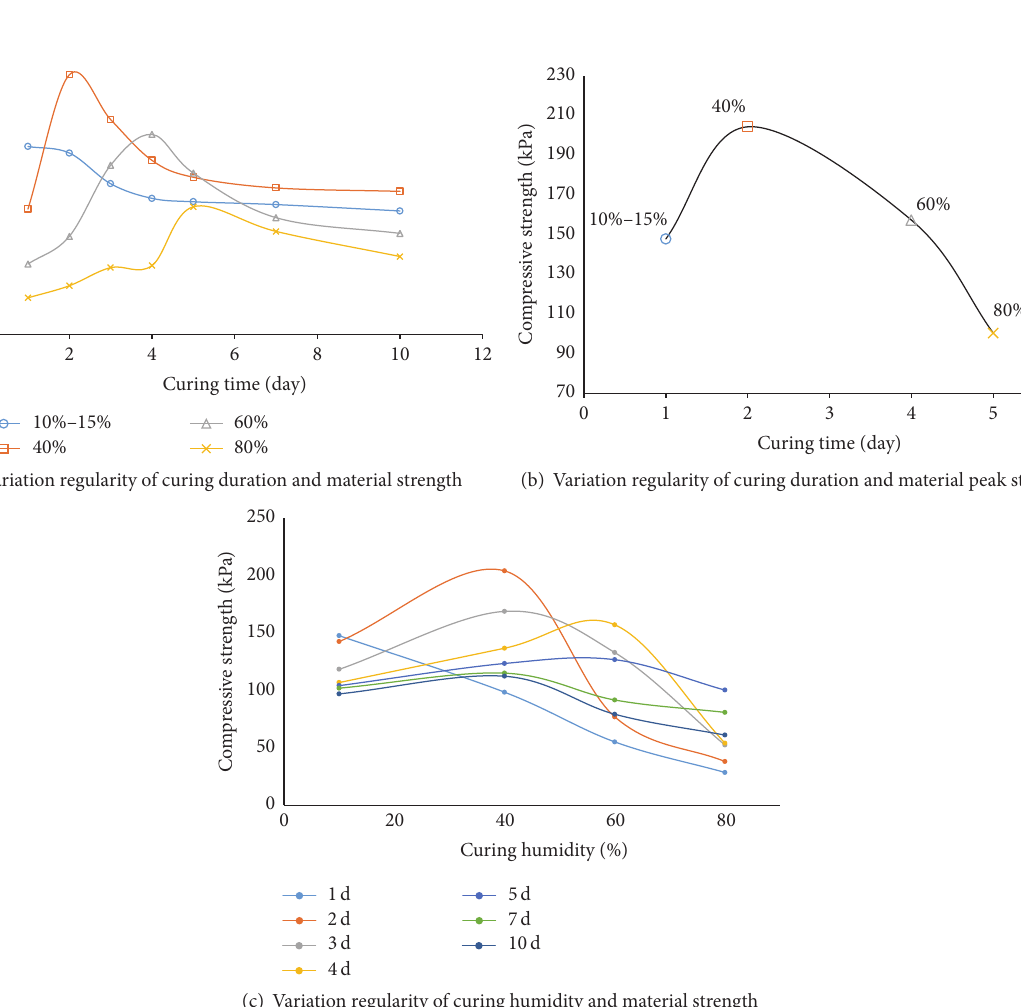
Figure 8: The relationship between curing duration, humidity, and